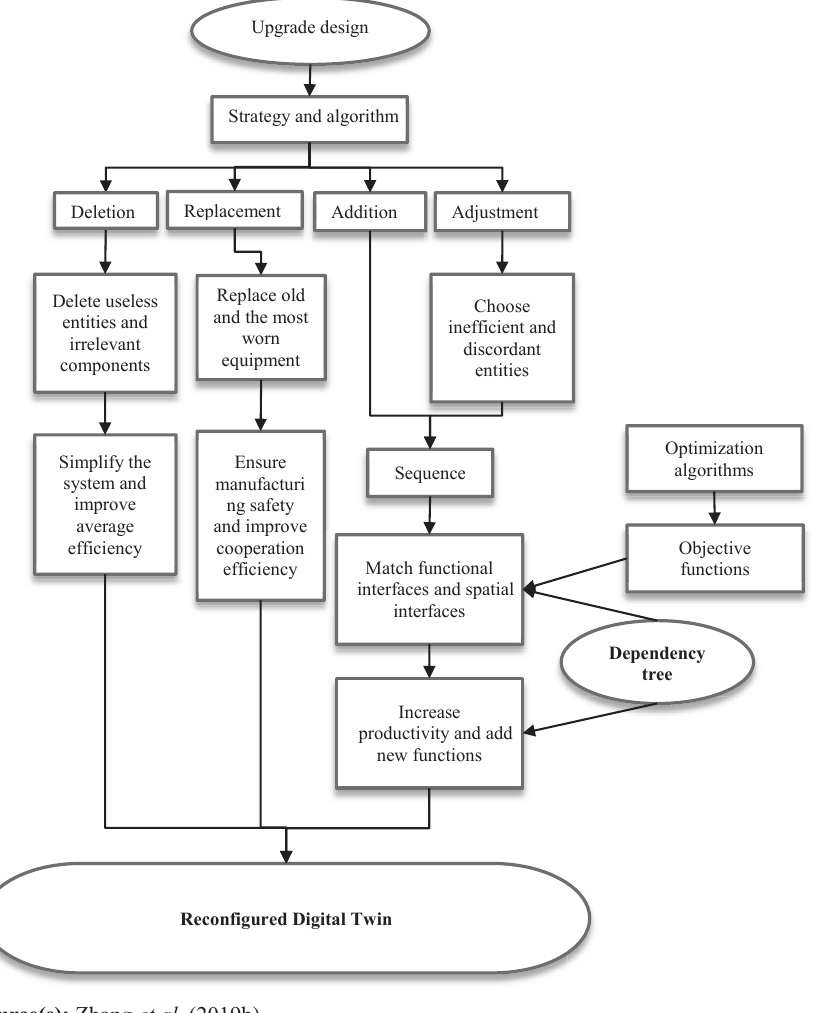
Figure 6. Process of